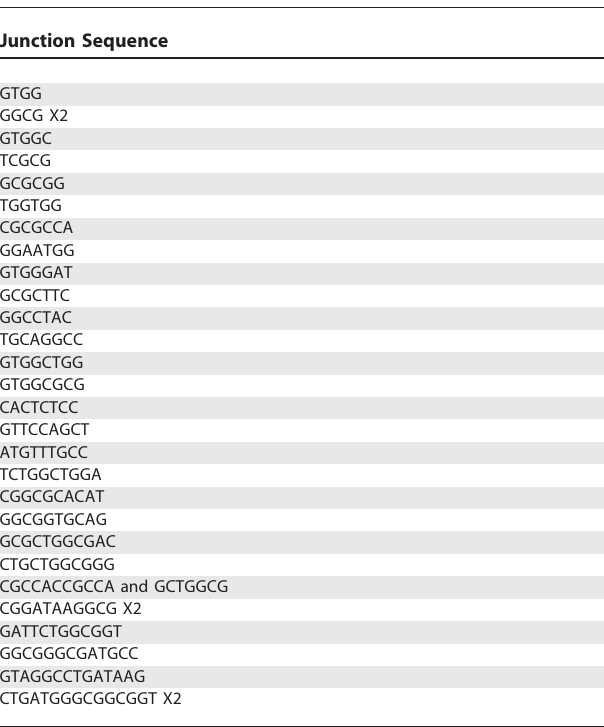
Table 1. Sequences of 31 Novel Junctions from Stress-Induced